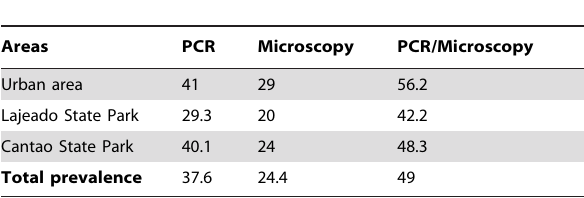
Table 1. Prevalence (%) of Plasmodium / Haemoproteus in the three different areas studied by PCR and microscopy